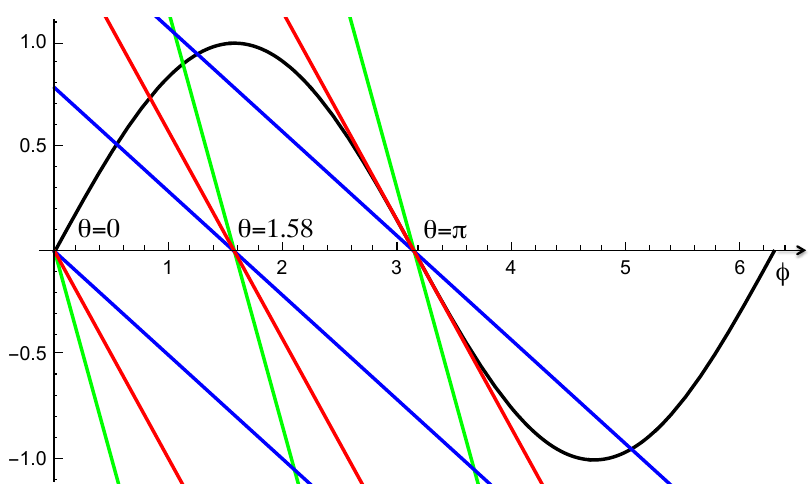
Figure 1 . Solutions of V 0 ( (cid:30) ) = 0 are given by the intersections of the curve sin (cid:30) (black) with the straight lines ( (cid:18) (cid:0) (cid:30) ) =(cid:15) for (cid:18) = 0, (cid:18) = (cid:25) and a generic value taken to be (cid:18) = 1 : 58. Code color is as follows: (cid:15) < 1 green lines, (cid:15) = 1 red lines, (cid:15) > 1 blue